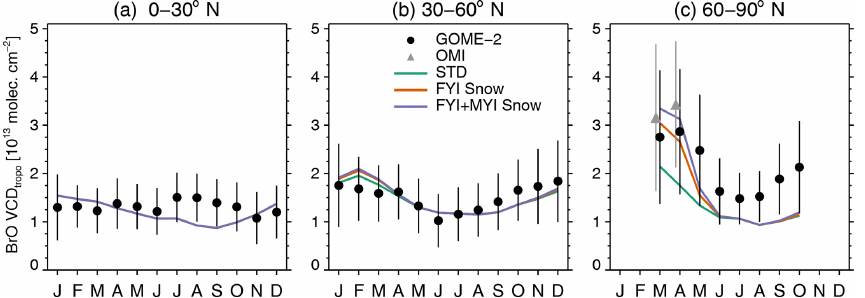
Figure 1. Seasonal variation in 2007–2009 monthly mean tropospheric BrO vertical column densities (VCD tropo in units of 10 13 moleculescm − 2 ) observed by GOME-2 (black circles) and OMI (gray triangles in panel c for April and May) and simulated with GEOS-Chem over (a) 0–30 ◦ N, (b) 30–60 ◦ N, and (c) 60–90 ◦ N. The three GEOS-Chem simulations shown are the standard simulation (STD, green line) and two blowing-snow simulations (FYI Snow, orange line, and FYI+MYI Snow, purple line). The black and gray error bars represent 1 standard deviation about the monthly mean GOME-2 and OMI VCD tropo . For each latitude bin, we only show means for months where at least 70% of the surface area has valid satellite observations.